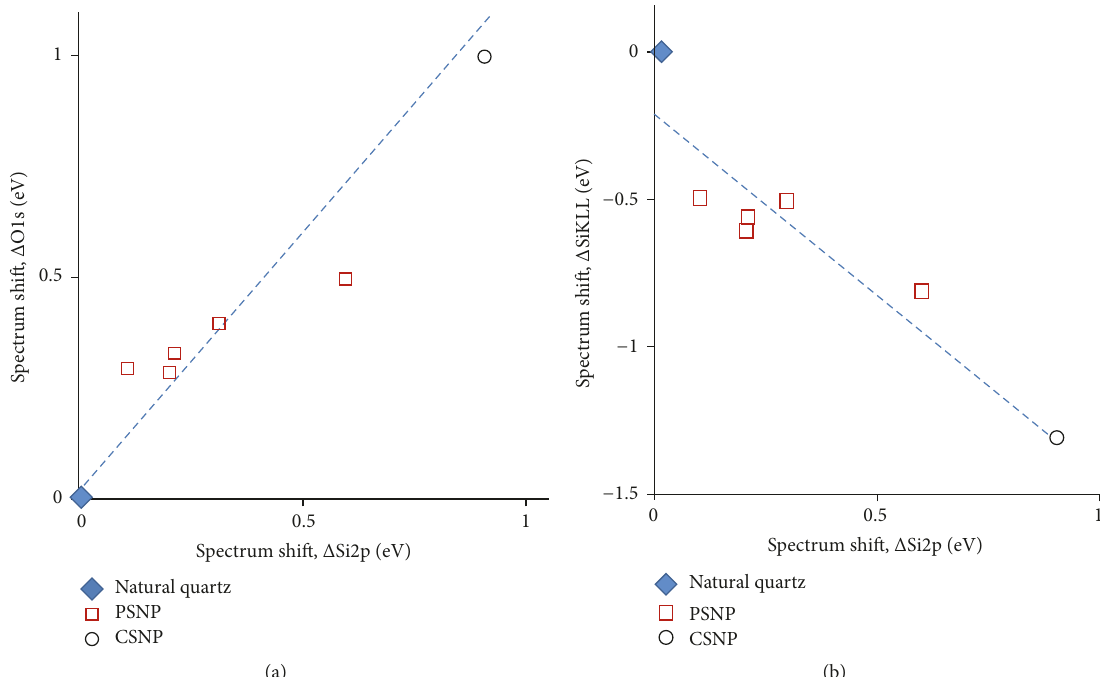
Figure 2: X-ray emission spectroscopy of natural quartz, PSNP, and CSNP, where there are (a) shifts of the O1s and Si2p spectra and (b) shifts of the Auger and Si2p